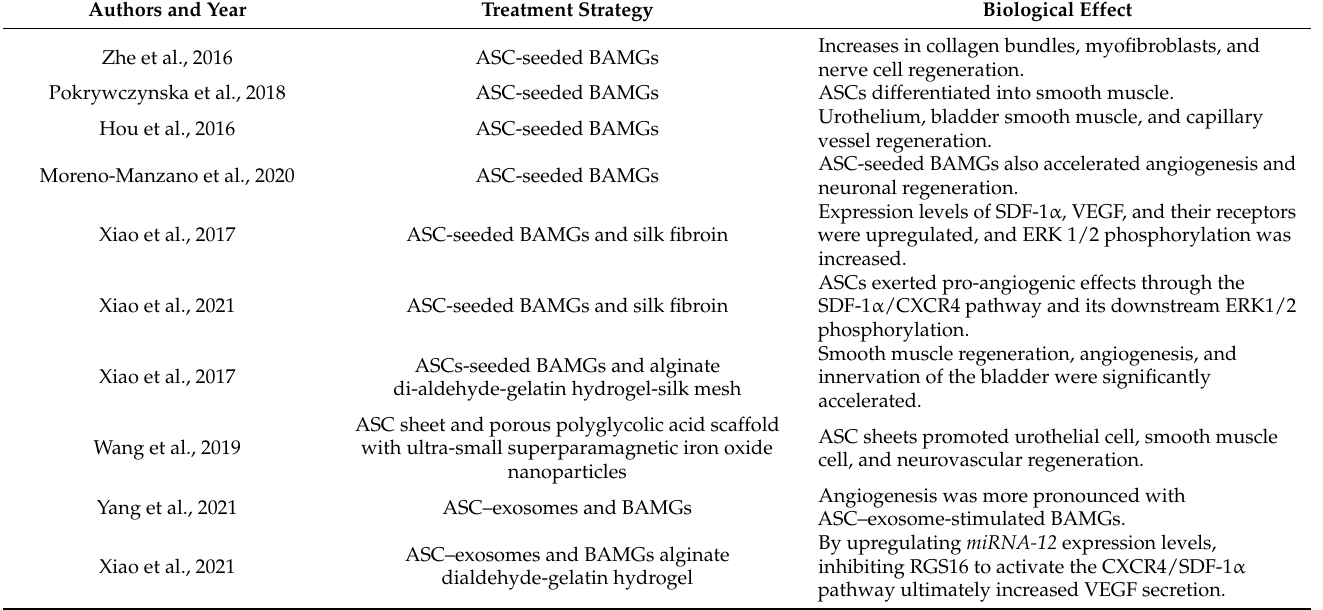
Table 1. Overview of ASC-based therapy for bladder